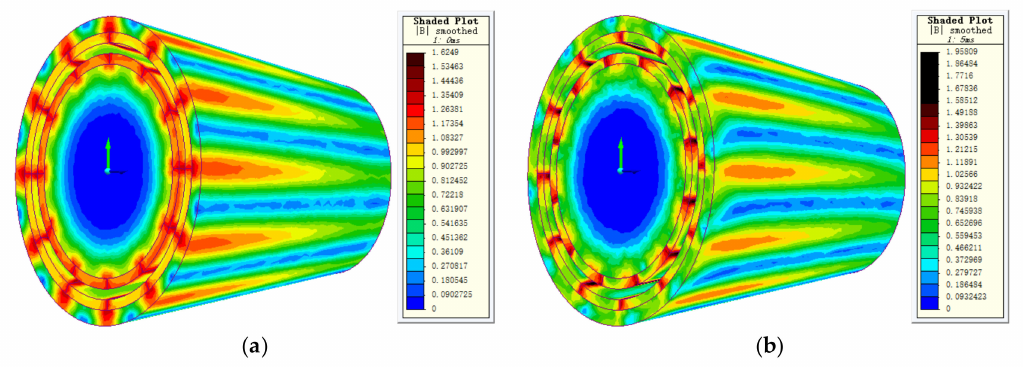
Figure 4. Flux distribution of the initially designed CPMC obtained by 3D-FEM. ( a ) At the aligned position. ( b ) At the maximum pull-out torque